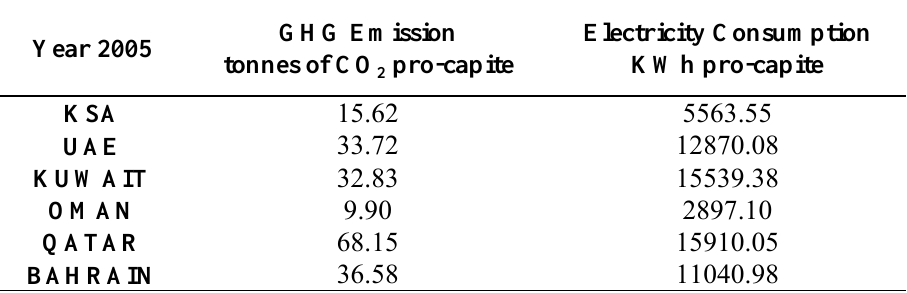
Table 4. Electricity consumption and GHG emission.